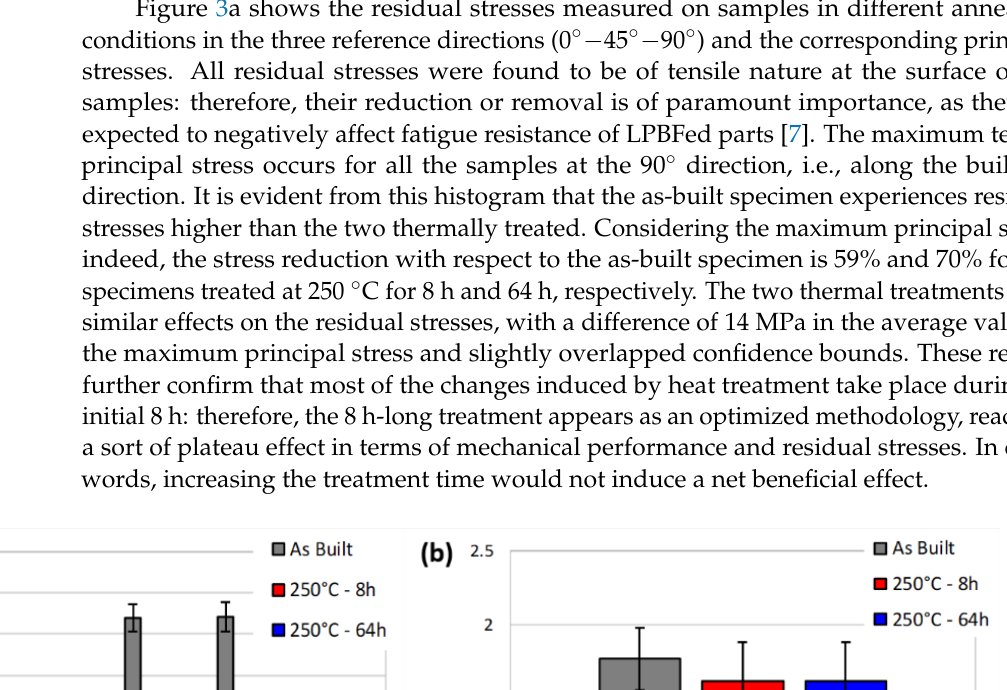
Figure 2. ( a ) evolution of hardness upon isothermal annealing at 250 ◦ C; ( b ) tensile curves of as-built and annealed samples.